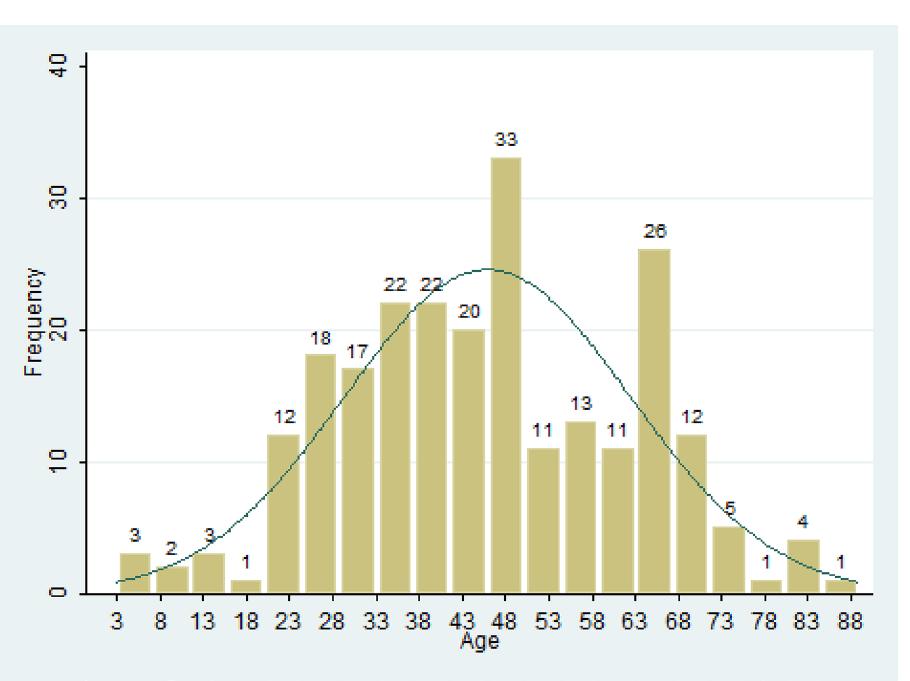
Figure 1. Age distribution of COVID-19 Cases in Shaanxi Province,